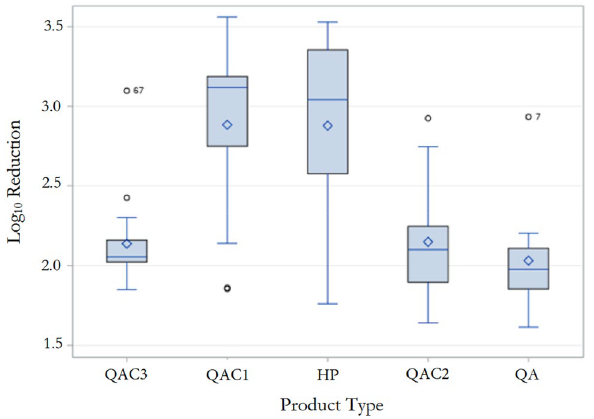
Figure 2. Mean log 10 reductions for each product type against C. auris regardless of contact time. HP had the highest variability among products tested followed closely by QAC1. HP and QAC1 had significantly higher levels of fungicidal disinfect efficacies compared to QAC2, QAC3, and QAC-alcohol; (α = 0.05). ◇ Mean, —